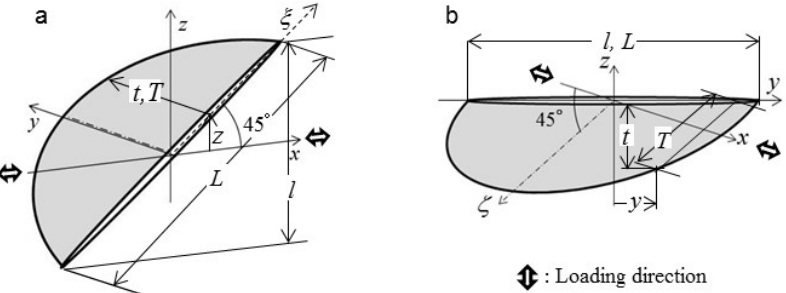
Figure 7: Definition of the crack length/depth for inclined cracks: (a) the zx -plane crack; (b) the xy -plane